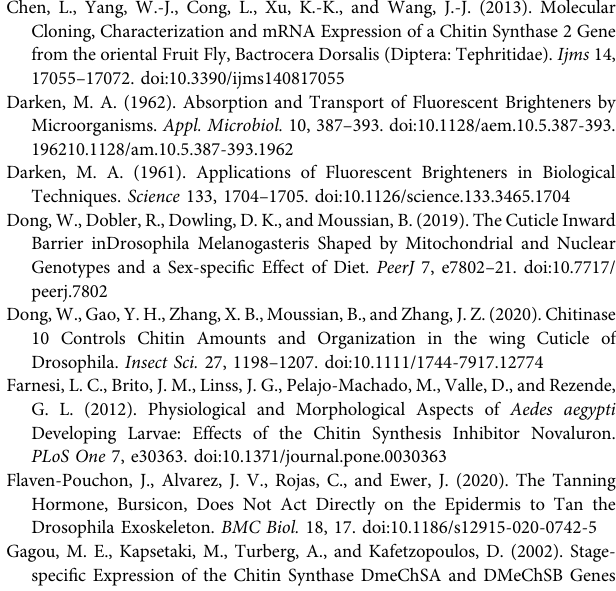
SupplementaryFigureS2| RelativeFB28intensityofthe pnr zoneintheabdomen after RNAi down-regulation of chitin-related genes. Pnr zone data from Figure 3 are expressedasapercentageof pnr — zonefromthesame fi gure.Dataarerepresented as scattergrams showing all data points with the mean (red crosses).